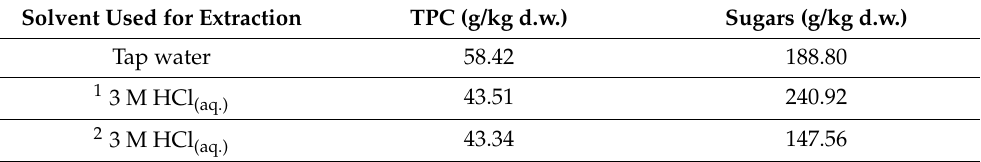
Table 2. Comparison of water and hydrochloric acid as solvents for solid–liquid extraction. Solvent Used for Extraction TPC (g/kg d.w.)